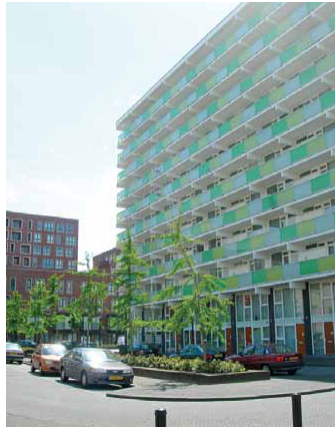
fig. 6. Bijlmermeer estate in amsterdam fig. 7. Bijlmermeer estate in